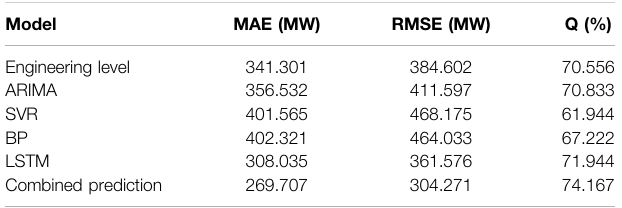
TABLE 1 | | Model prediction accuracy comparison.